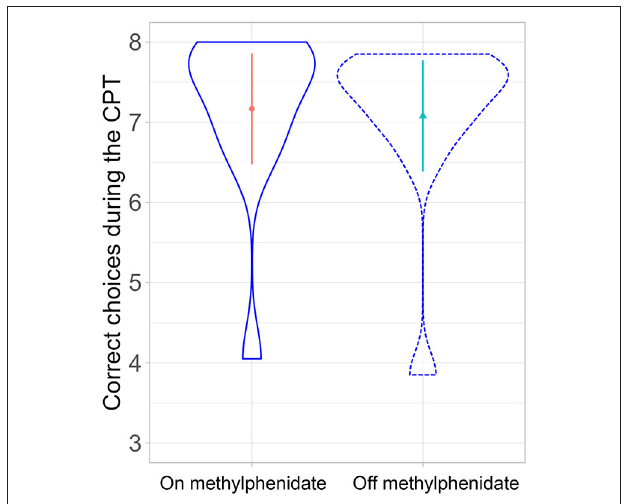
FIGURE 4 | Comparison of correct choices in the continuous performance task on- and off-MPH ( p -value: 0.47).